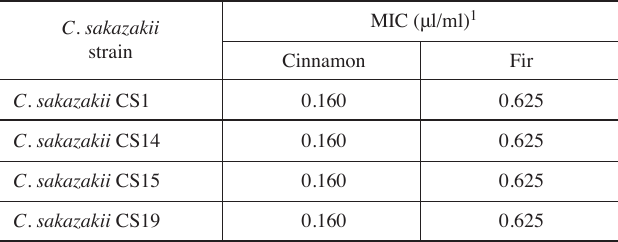
Tab. 2: Minimum inhibitory concentration (MIC) values of cinnamon and fir oils against 4 C. sakazakii strains at 37 °C.